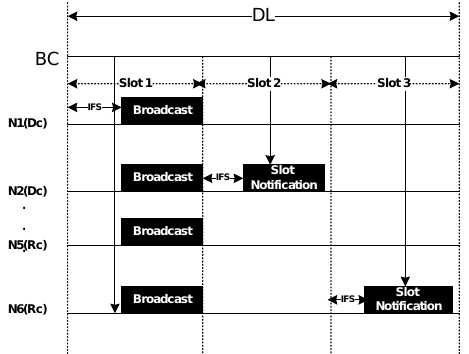
Figure 8. Communication during Download (DL)